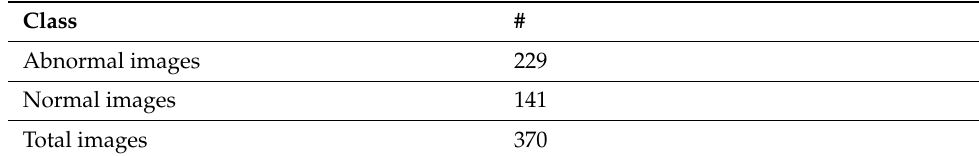
Table 4. Dataset-I details.